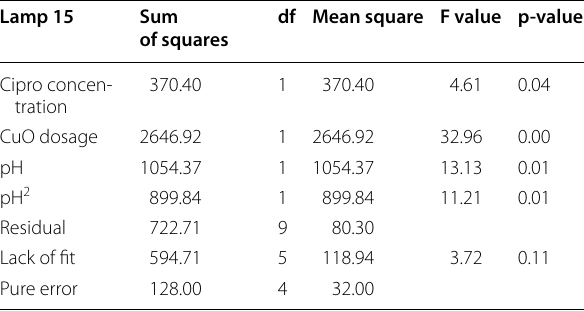
Table 4 Analysis of variance (ANOVA) results for the fitted polynomial model for COD removal using photocatalytic process with lamp 15-W